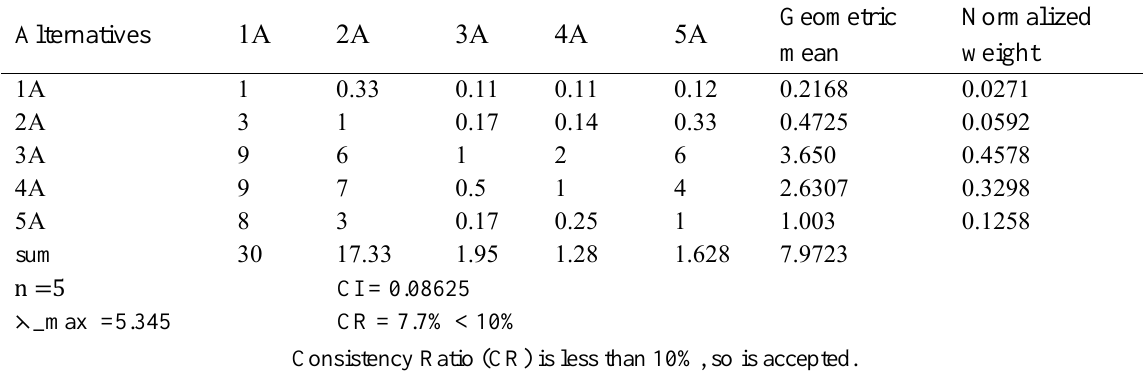
Table 6. Comparison Matrix of Alternatives with respect to C2.